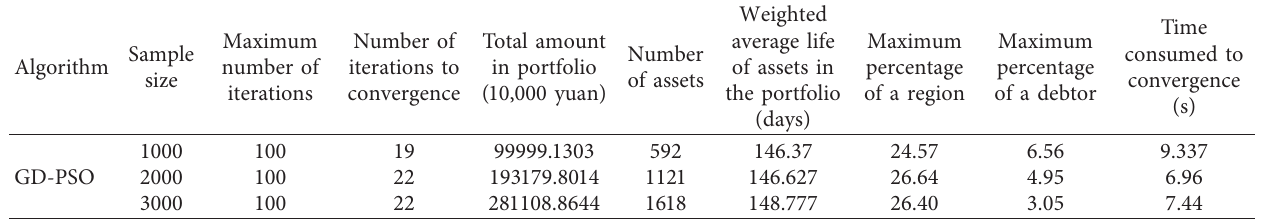
Table 3: GD-PSO performance testing of algorithms.